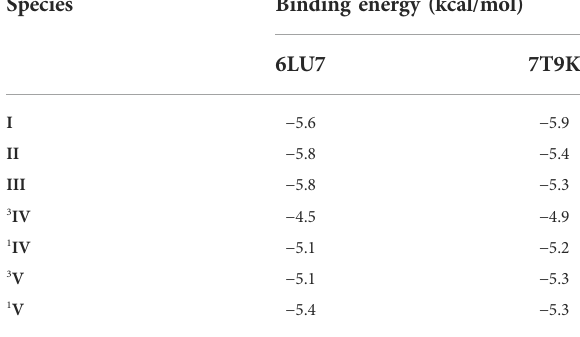
TABLE 4 Favourable binding energies (docking scores) for the docked poses for species I-V with the selected SARS-CoV-2 proteases.